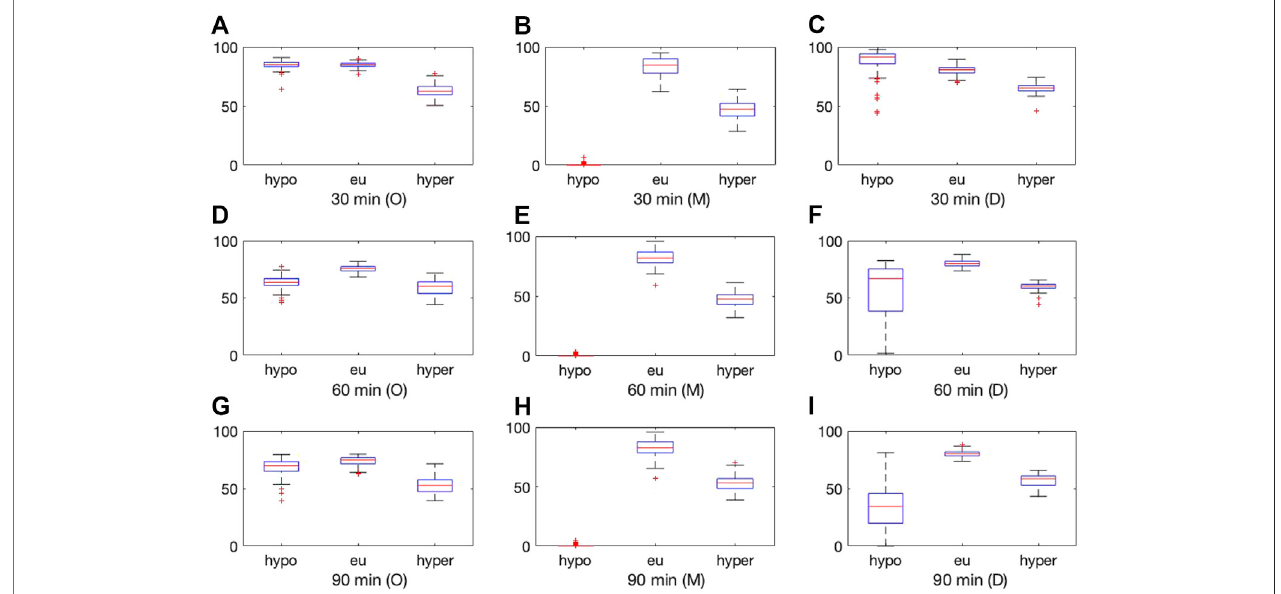
FIGURE5| Boxplotforthe100experimentsconductedwith50%trainingdataforeachpredictionmethod(O (cid:2) ourmethod,M (cid:2) MATLABDeepLearningToolbox, D (cid:2) diffusion geometry approach) witha 30 min ( top ),60 min ( middle ) and 90 min ( bottom ) prediction horizon and dataset D. Each of thegraphsshow the percentage accurate predictions in the hypoglycemic range ( left ), euglycemic range ( middle ) and hyperglycemic range ( right ).